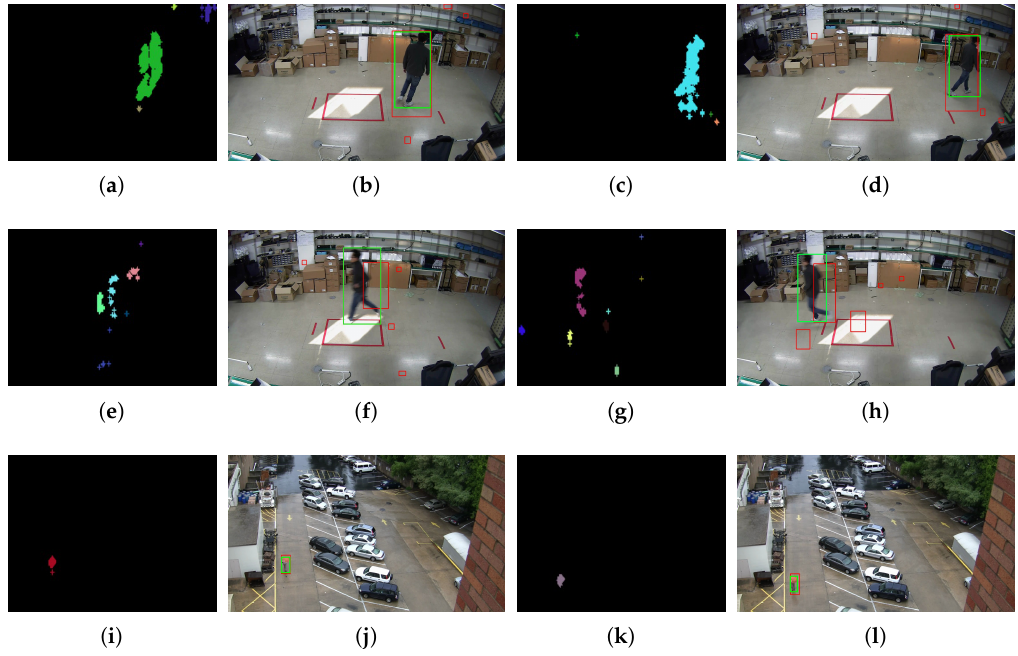
Figure 13. Moving object detection by the proposed method in different scenarios: ( a – d ) human walking; ( e – h ) human running; ( i – l ) test with a far distance of the camera. The green bounding boxes shown in the figure are ground-truth bounding boxes, while the red bounding boxes are detected objects using the proposed method. The average IoU scores are shown in detail for each scenario in Table 4. The results show that when a camera is placed at a close distance and the human does not move fast (i.e., human walking), the proposed method detected the human well and achieved a good average IoU score of 0.75. However, when the speed of the human was fast as in case of running or the camera was at a far distance, the MV’s density decreased, and the detector returned lower average IoU scores. For object tracking evaluation, the scenarios were run multiple times with different detection score thresholds α of 0.25, 0.4, and 0.5 with the results shown in Figure 14. Table 4. Average IoU of the moving object detection in the compressed-domain in different